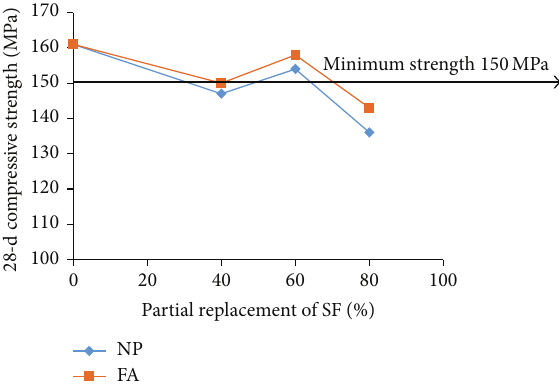
Figure 4: Variation of compressive strength with replacement of SF by NP and FA.